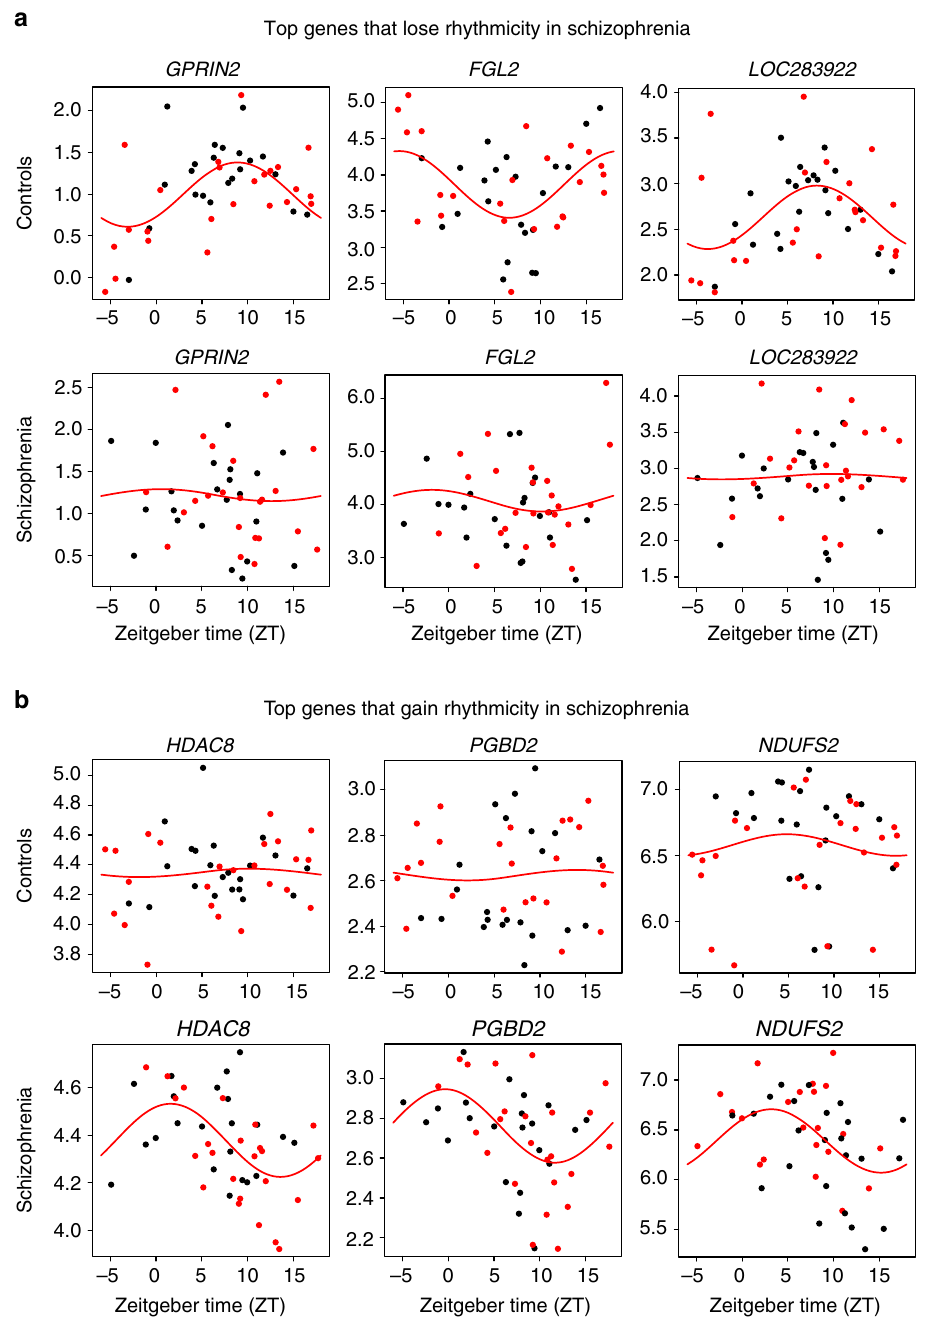
Fig. 3 Scatterplots indicating rhythmicity for genes that lose or gain rhythmicity in subjects with schizophrenia compared to controls. Each dot indicates a subject with x -axis indicating the time of death (TOD) on ZT scale ( − 6 to 18 h) and y -axis indicating gene expression level. Subjects from the Pitt brain bank are in black while subjects from the MSSM brain bank are in red. The red line is the fi tted sinusoidal curve. a Scatterplots indicating rhythmicity of GPRIN2 ( p < 0.0005), FGL2 ( p < 0.002), and LOC283922 ( p < 0.002) in healthy controls (top), which lose rhythmicity in subjects with schizophrenia (bottom). b Scatterplots indicating lack of rhythmicity of HDAC8 , PGBD2 , and NDUFS2 in control subjects, but these genes gain rhythmicity in subjects with schizophrenia ( HDAC8 : p < 0.0005; PGBD2 : p < 0.001; NDUFS2 : p <